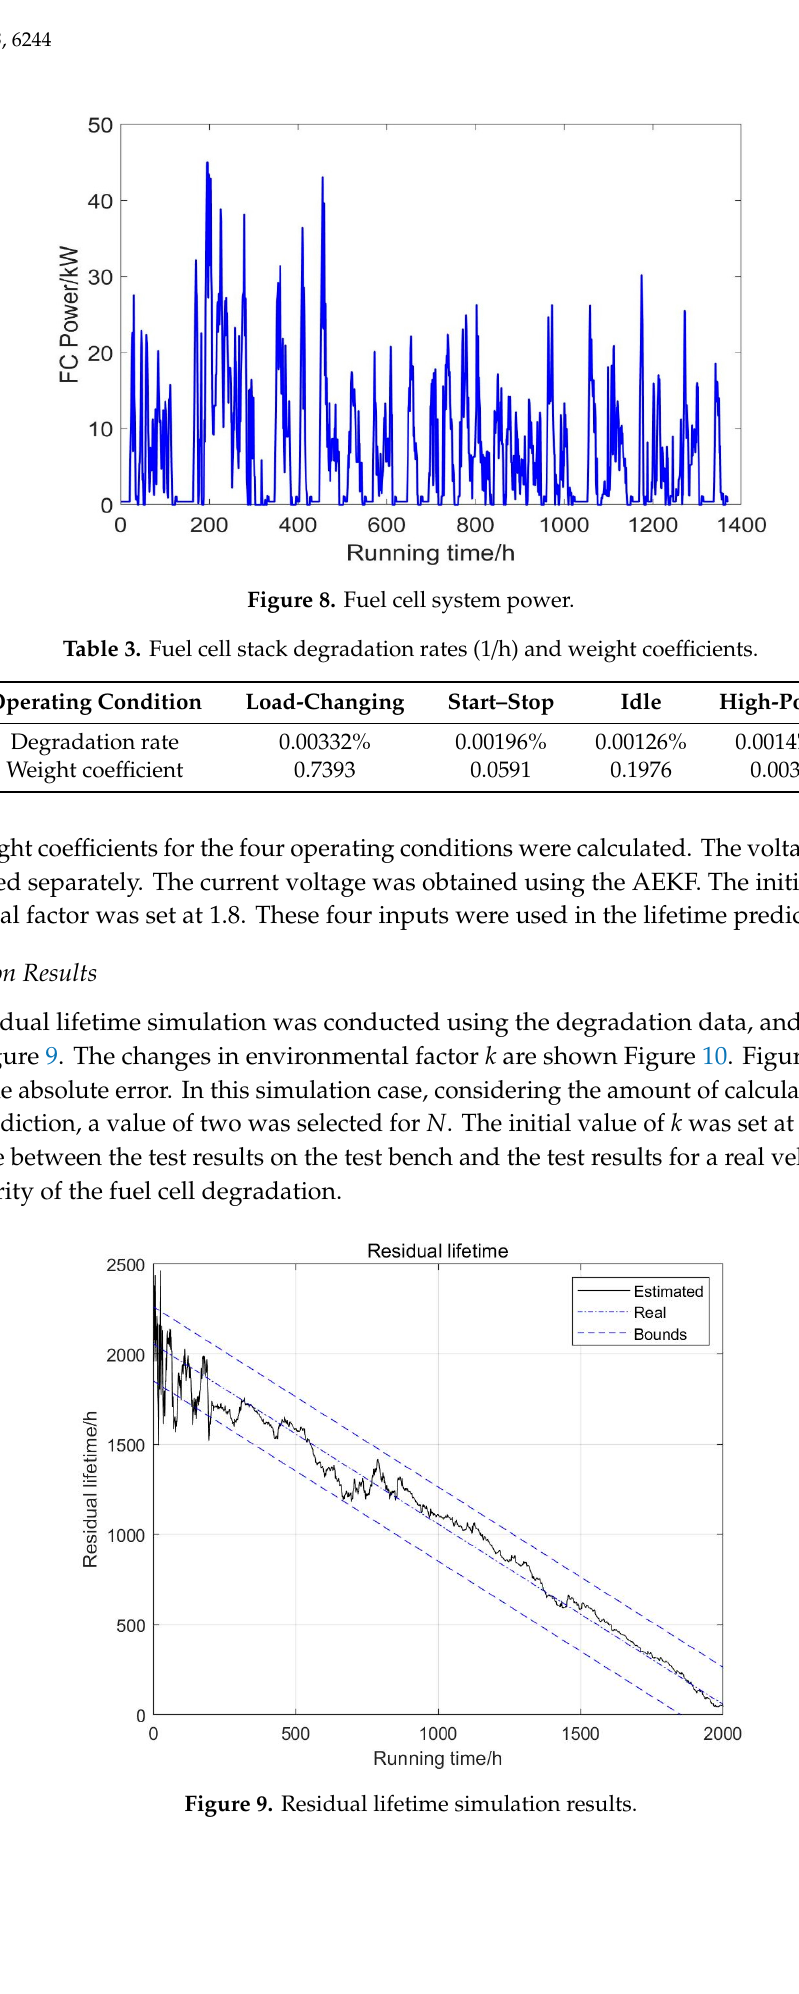
Figure 9. Residual lifetime simulation results.